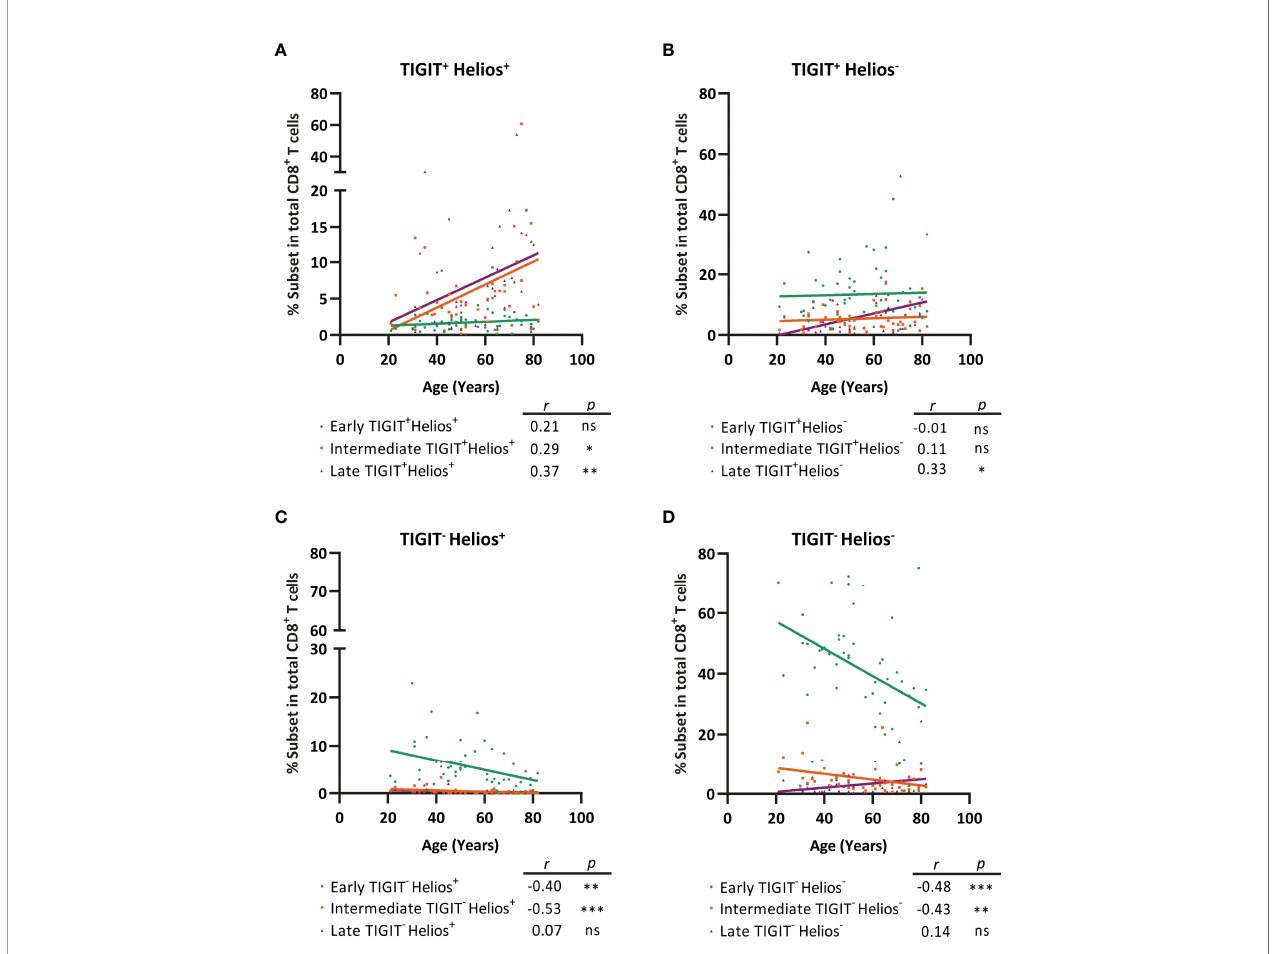
FIGURE 7 | TIGIT + Helios + intermediate- and TIGIT + Helios + late-differentiated cells accumulate with age within the total CD8 + T-cell population at the cost of TIGIT - Helios + and TIGIT - Helios - cells. Frequency of early-, intermediate-, or late-differentiated (A) TIGIT + Helios + cells, (B) TIGIT + Helios - cells, (C) TIGIT - Helios + cells, and (D) TIGIT - Helios - cells within the total CD8 + T-cell population and their relationship with age (n = 50). Correlations ( r and p values) were assessed by Spearman test with p < 0.05 considered as statistically signi fi cant. (* p < 0.05, ** p < 0.01, *** p < 0.001, ns, not signi fi